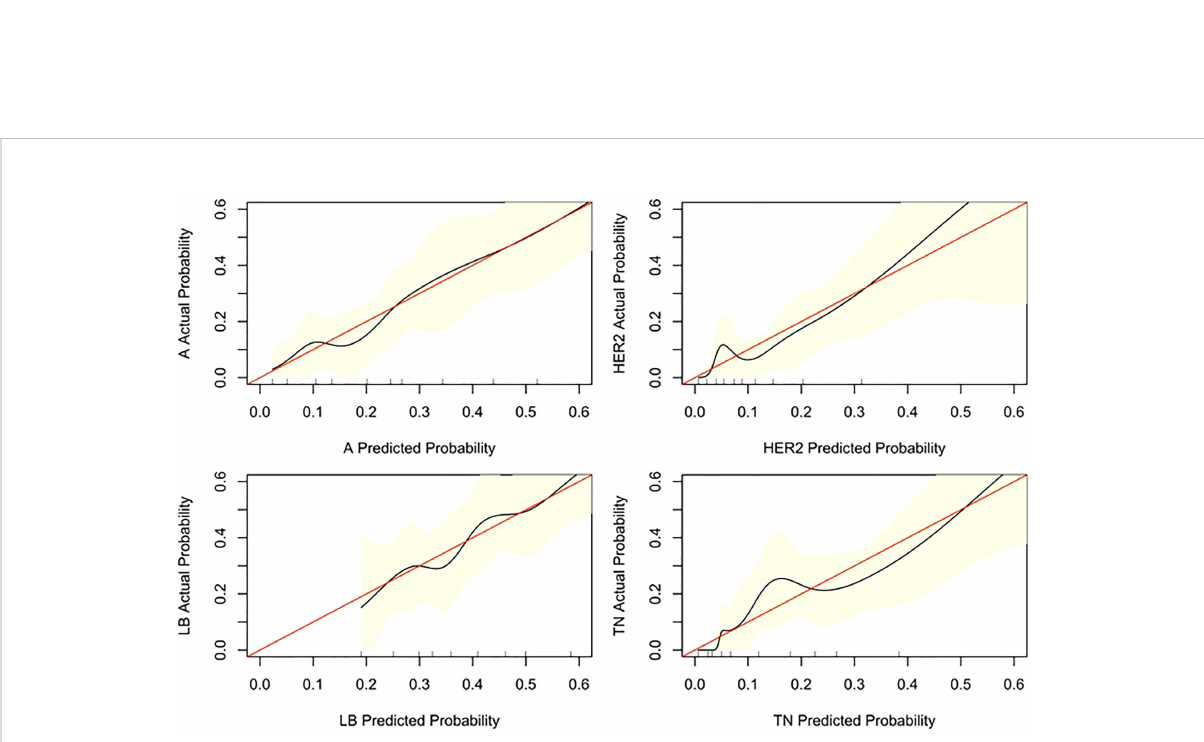
FIGURE 5 Calibration curve of the nomogram. The diagonal line indicates the ideal nomogram